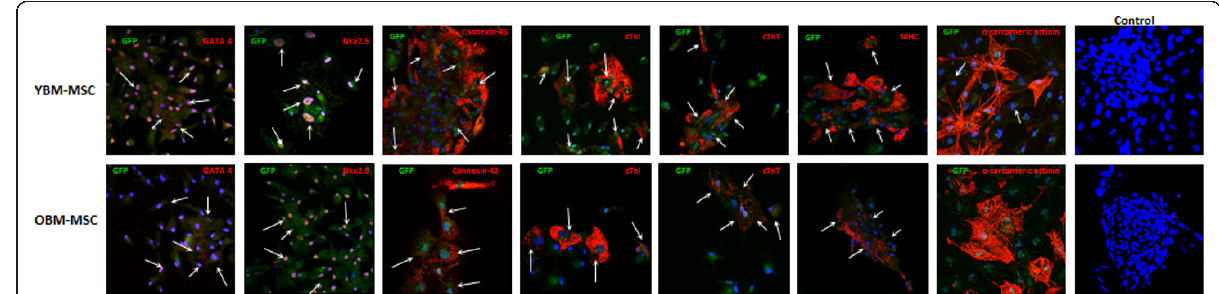
Figure 5 Immunocytochemical analysis of Cardiomyogenic differentiation of BM-MSCs co-cultured with NVCM: Results of co-culture with NVCM after 14 days . Representative micrographs of anti-GATA 4, Nkx2.5, connexin-43, cTnI, cTnT, MHC and a -sarcomeric actinin staining in cultured BM-MSCs from each experimental